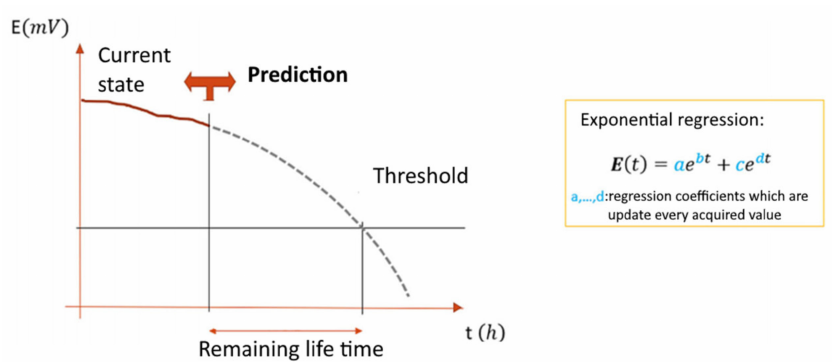
Figure 5. Estimation of the remaining mortar life using a controlled